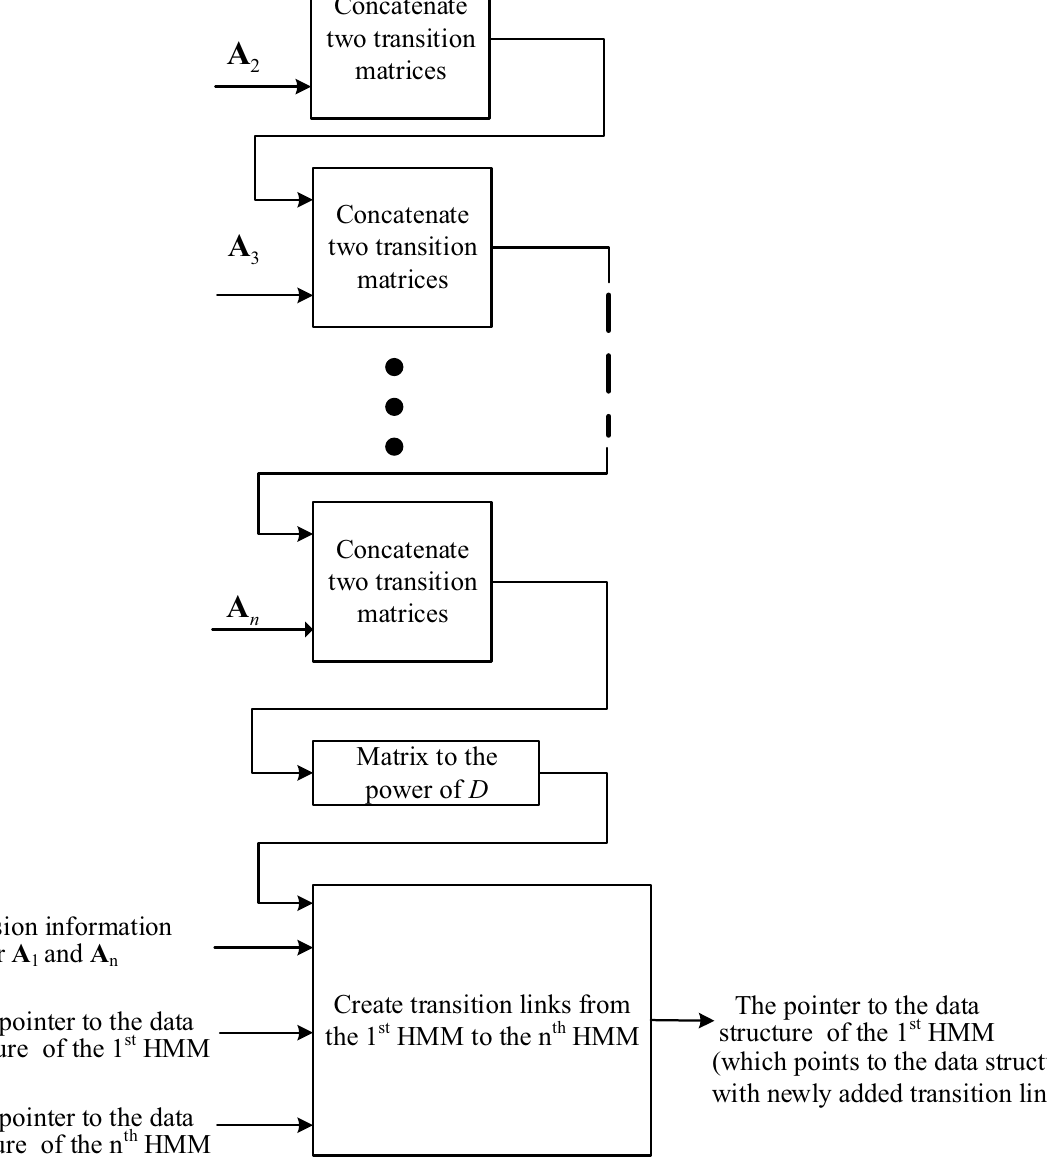
Fig 10. Creation of transition links from the 1 st HMM to the n th HMM for frame-rate reduction factor D using the connecting-then-adapting approach.